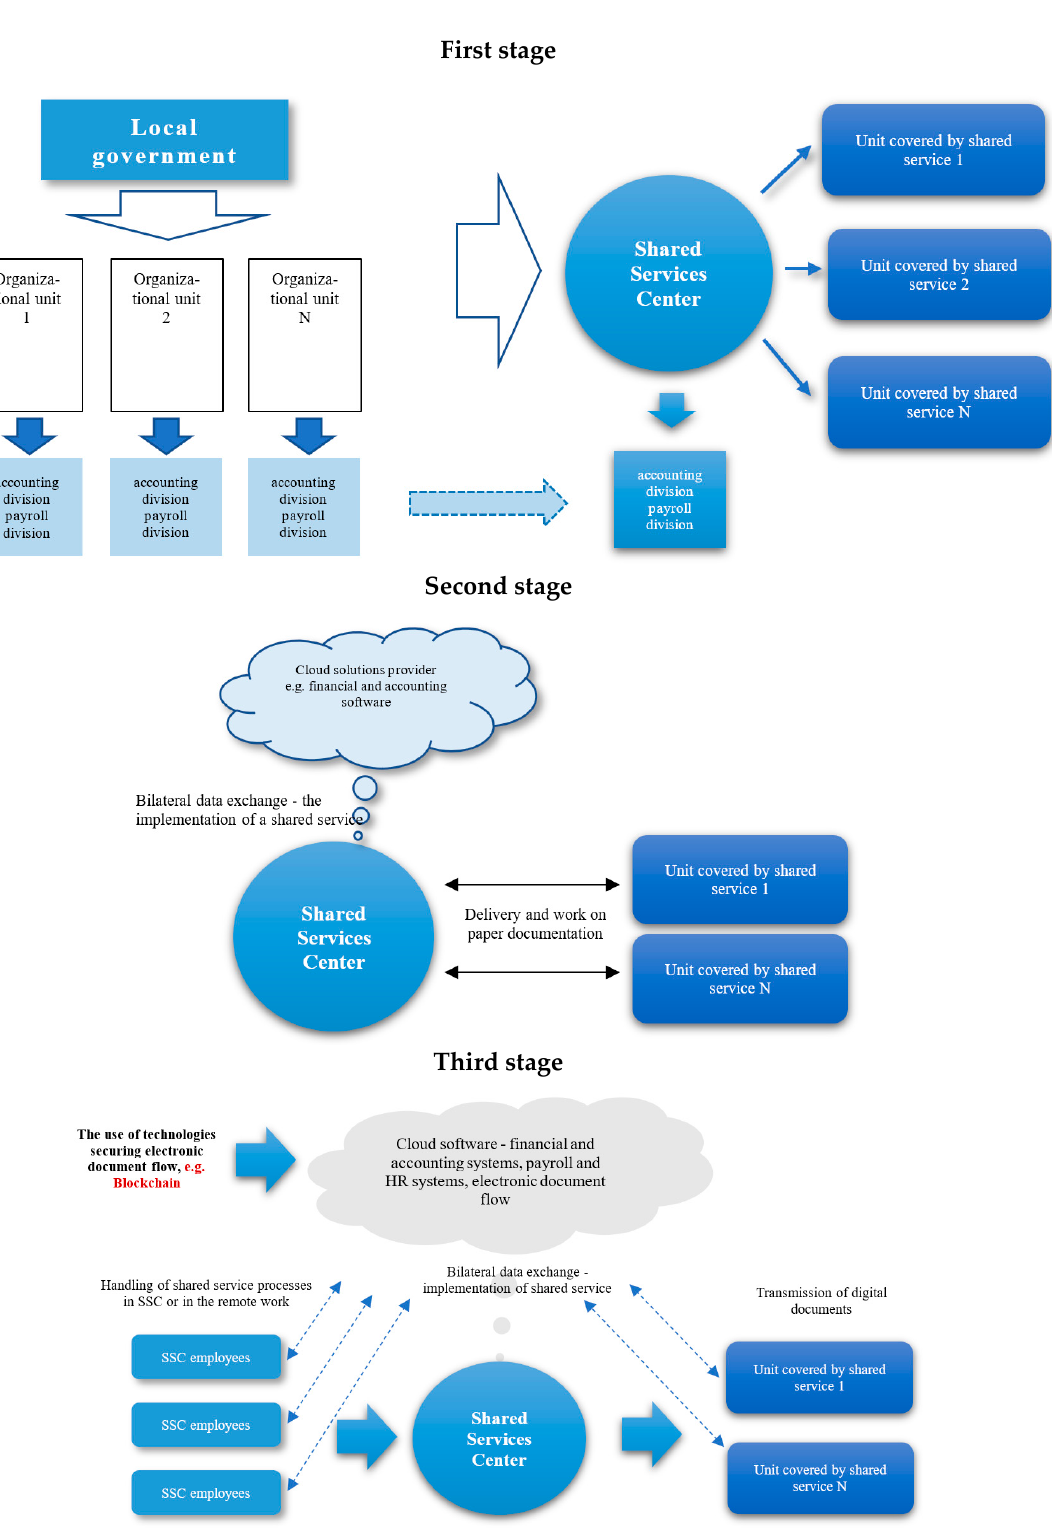
Figure 4. The process of creating local government shared services centers in Poland. Source: own study based on the conducted